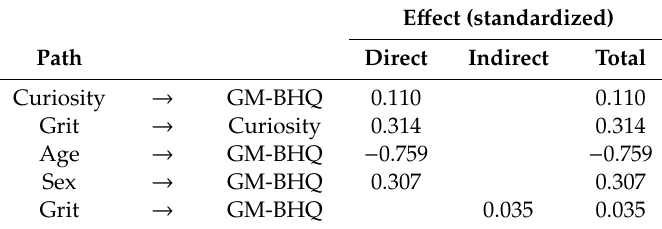
Table 5. Path coe ffi cient and direct / indirect e ff